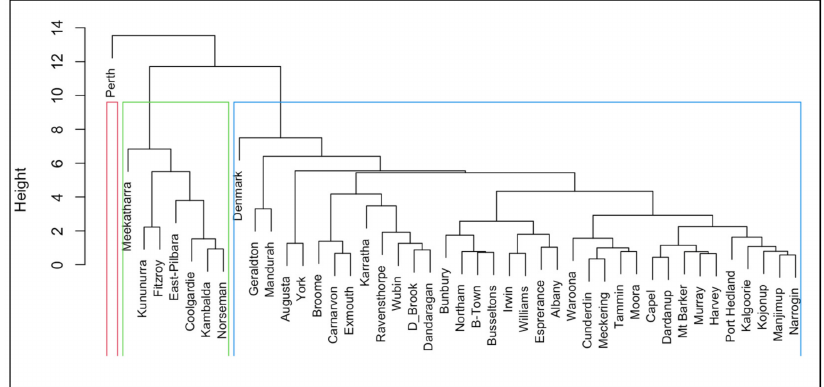
Figure 4. Hierarchical clustering of cities.